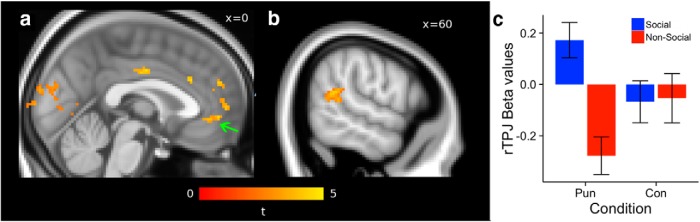
Activity and connectivity at the time of choice. a, Regions showing a positive correlation with the amount of monetary units participants decided to keep on each trial across all decision types. The green arrow indicates the vmPFC cluster used to extract time courses for the PPI analysis. b, Region of TPJ showing increased functional connectivity with vmPFC during strategic decisions made in social punishment compared with nonsocial punishment contexts. All voxels shown in a and b are significant at p < 0.05 after correcting for multiple comparisons. c, Bar graph showing the relative coupling between vmPFC and TPJ by treatment group and choice context and demonstrating that increased TPJ-vmPFC coupling is specific to choices that are both strategic and social in nature. Error bars represent the standard error of the mean for the group mean. These bar plots are presented for visualization purposes only and were not used as a basis for any statistical analysis.